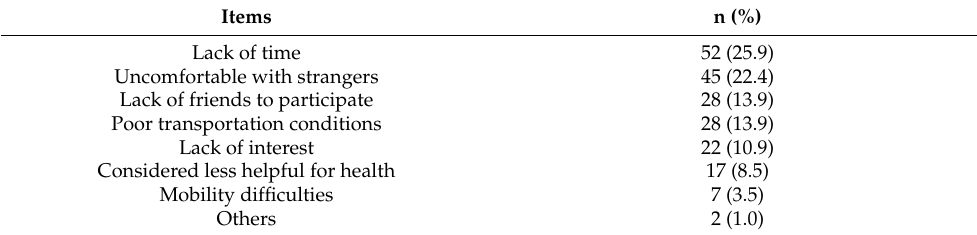
Table 4. Reasons for not participating in the forest healing program (N =